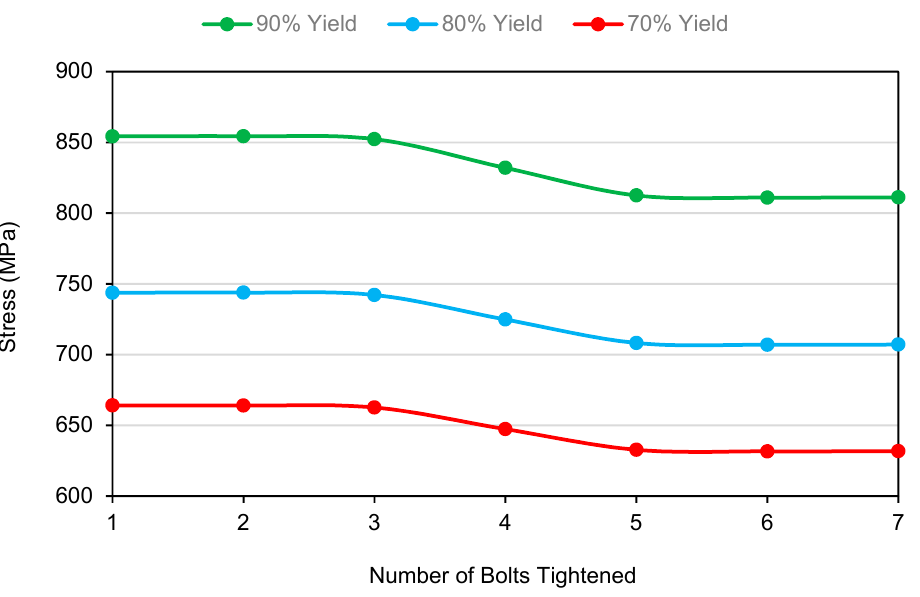
Figure 7. Comparison of bolt preload (Fp) reduction at three load levels .